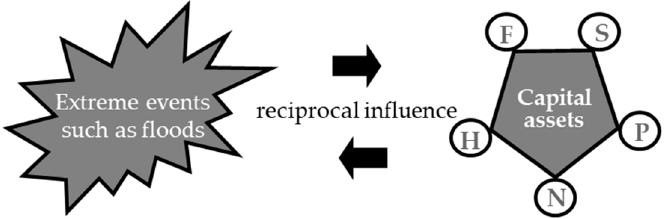
Figure 1. Capital asset pentagon of the SLF. Source: Excerpt from Buchenrieder and Möllers ([44], p. 18). Notes: S = Social capital, i.e., social networks. F = Own financial means and access to external finance. N = Natural resources, e.g., land. P = Physical assets. H = Human capital, e.g., labor, health.